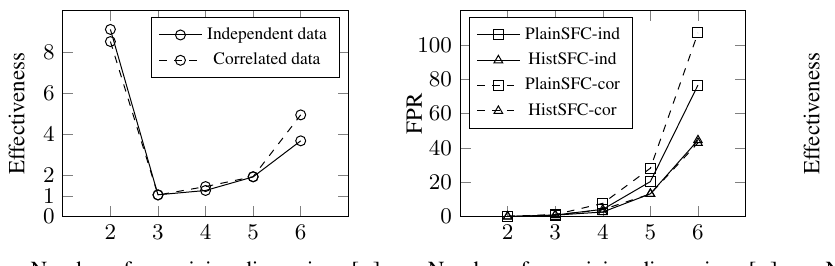
Figure 12. Effectiveness of HistTree for Figure 13. Mean FPR for n - n D query in Figure 14. Effectiveness of HistTree for